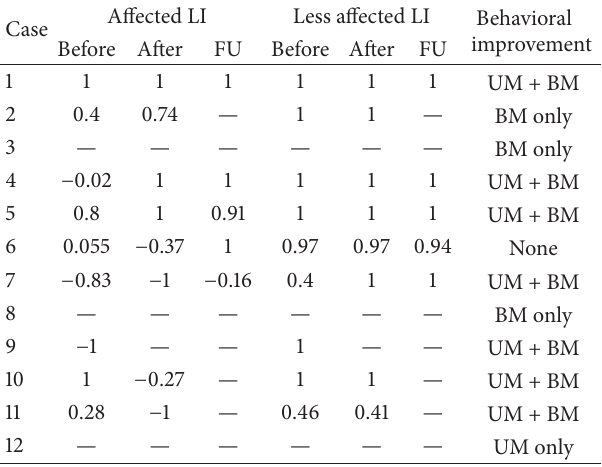
Table 3: Lateralization index for all participants across examina-